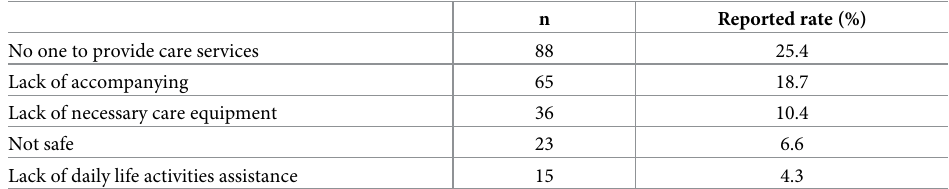
Table 7. Detailed concerns toward home-based care among the elderly(n =